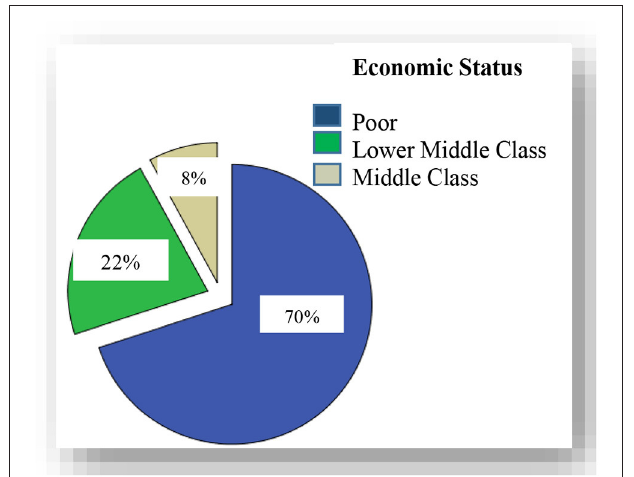
FIGURE 5 | Occupation of the respondent.